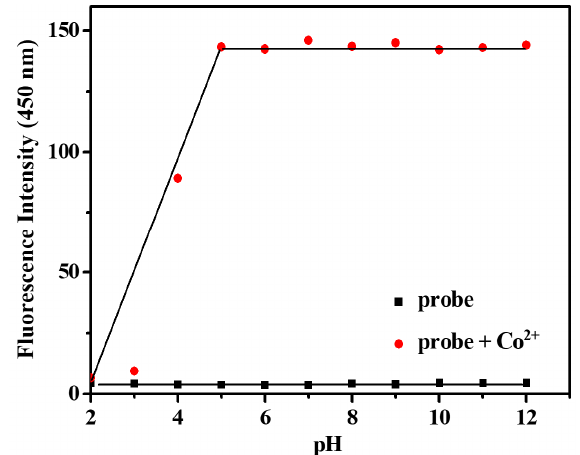
Figure 6. Effect of pH on the fluorescence intensity (450 nm) of L in the absence or presence of five equivalents of Co 2+ .